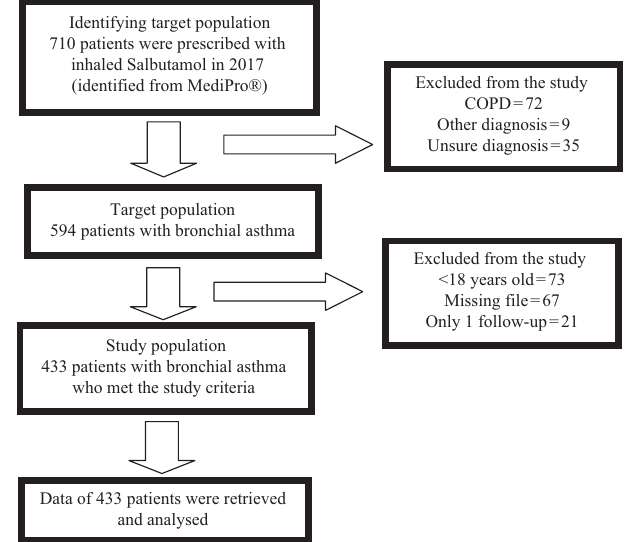
Figure 1. Flow of the